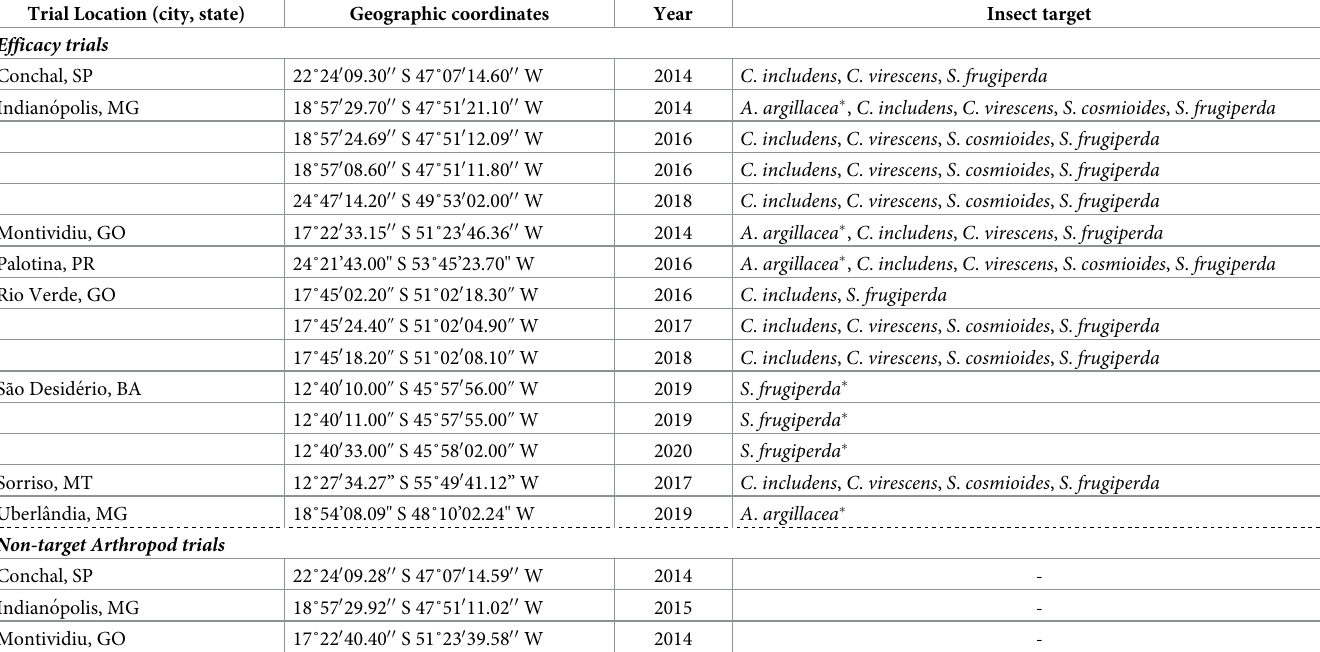
Table 1. Trial locations, target pests and infestation type for each study year (2014 to 2020) in